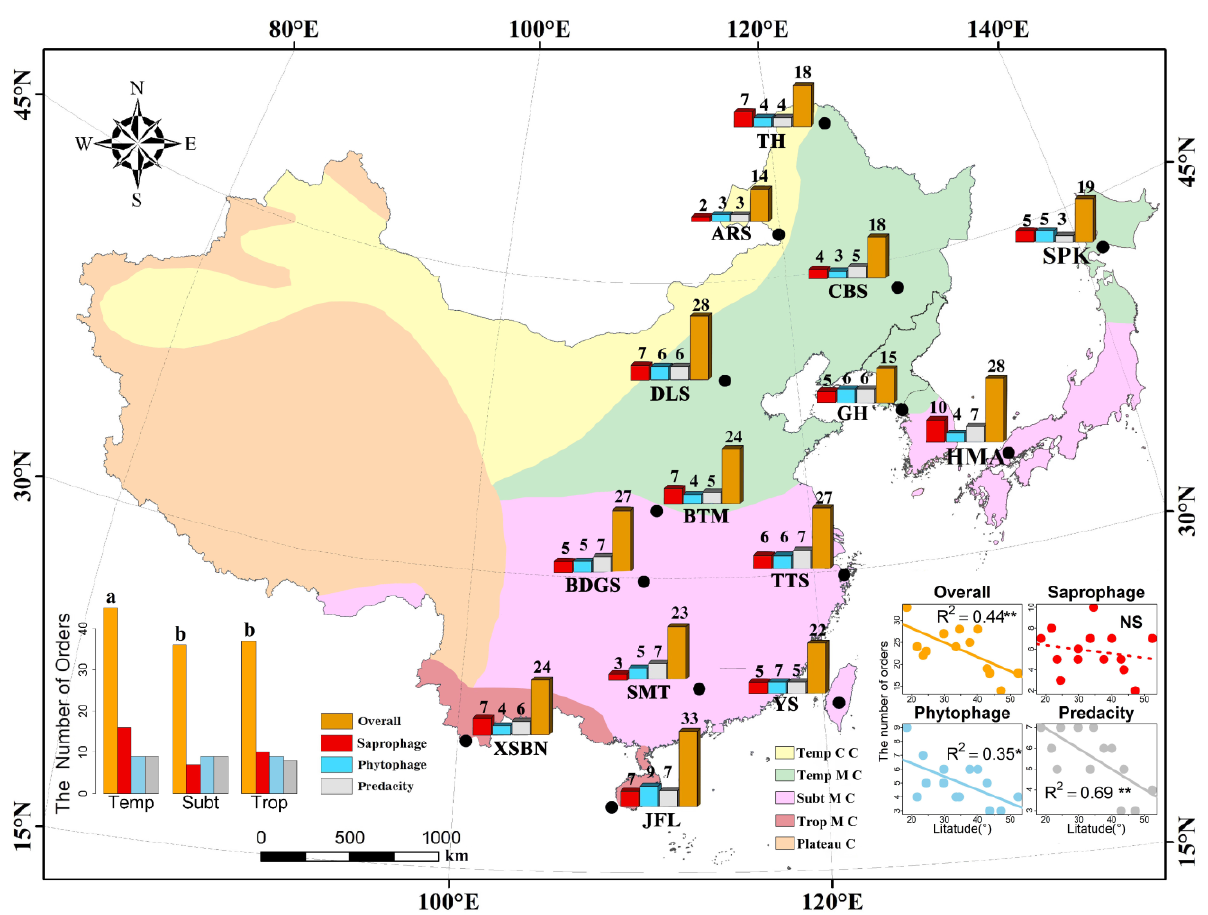
Figure 1. Locations of 14 sampling sites in East Asia, where TH = Tahe, ARS = Aershan, CBS = Changbaishan, DLS = Donglingshan, BTM = Baotianman, BDGS = Badagongshan, TTS = Tiantongshan, SMT = Shimentai, JFL = Jianfengling, XSBN = Xishuangbanna, GH = Guanghua, SPK = Sapporo, HMA = Hiroshima and YS = Yushan. The 14 sites belong to three climate zones, which are temperate zone (Temp), subtropical zone (Subt) and tropical zone (Trop). The graph on the bottom left shows the numbers of overall ( χ 2 = 7.582, p = 0.02), phytophagous ( χ 2 = 0.352, p = 0.839) and predatory ( χ 2 = 1.040, p = 0.595) orders in temperate, subtropical and tropical zones; “a” and “b” represent significant differences. The “Tem C C”, “Temp M C”, “Subt M C”, “Trop M C” and “Plateau C” represent, respectively, temperate continental climate, temperate monsoon climate, subtropical monsoon climate, tropical monsoon climate and plateau climate. The subset of graphs on the bottom right shows the relationship between the number of orders and latitude across the 14 sampling sites. Note: “NS” indicates p > 0.05, “*” indicates p ≤ 0.05 and “**” indicates p ≤ 0.01.